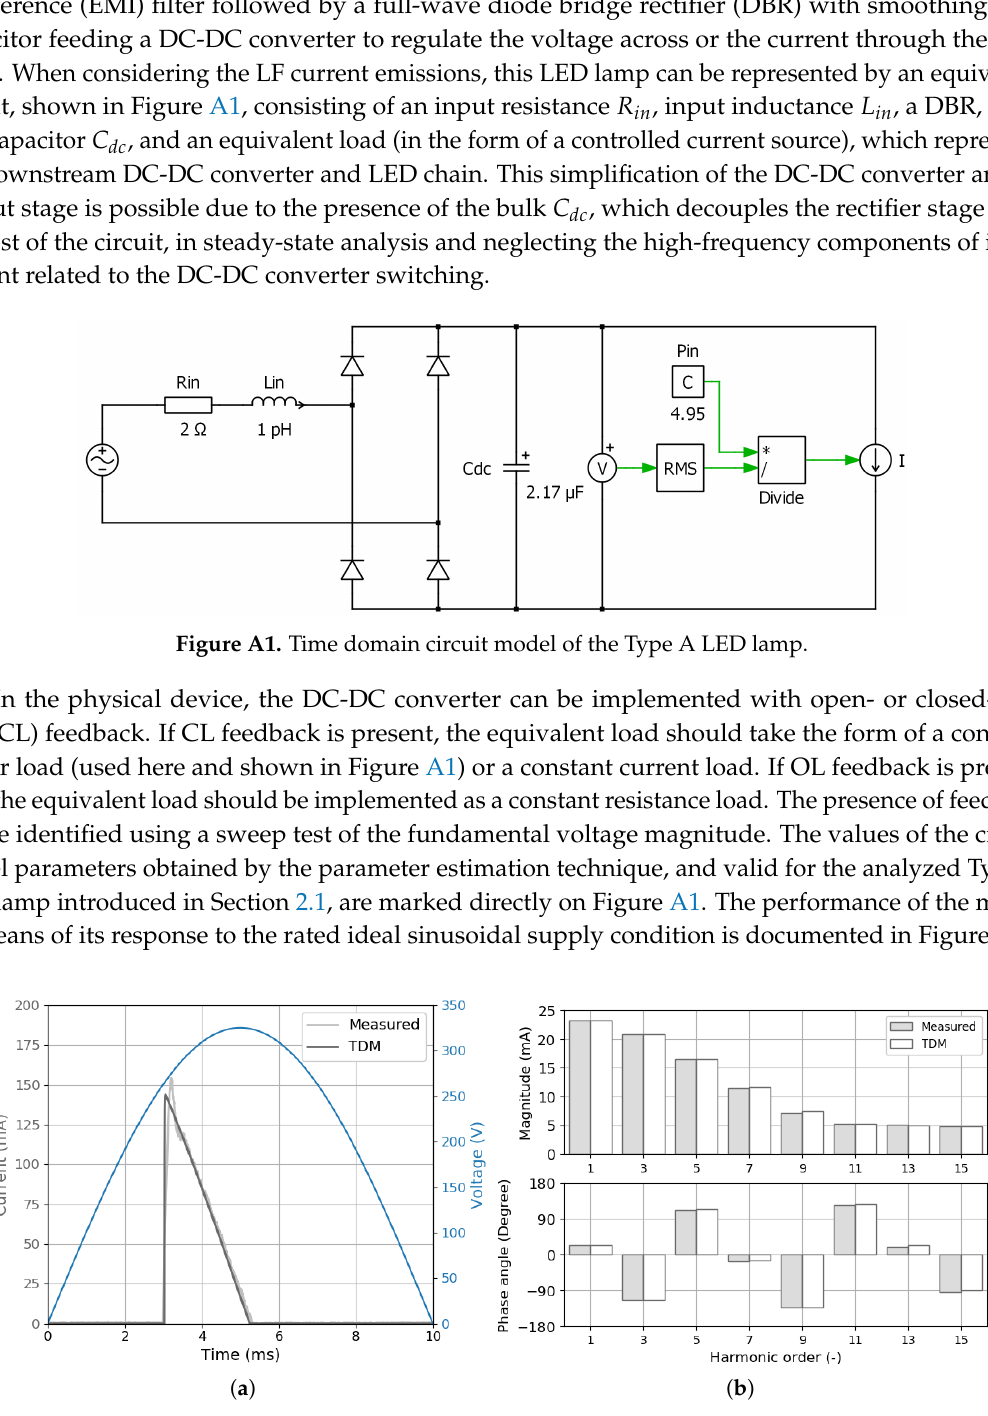
Figure A2. Comparison of measured data and the Type A LED lamp time-domain model (TDM) output at rated ideal sinusoidal condition: ( a ) Time domain. ( b ) Spectral